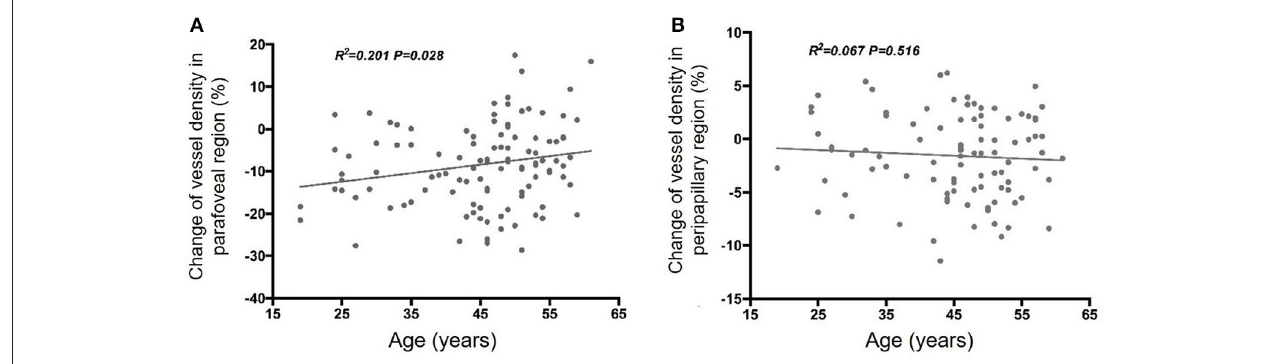
FIGURE 2 | Correlation between age and Valsalva maneuver-induced response of retinal perfused vessel density in the parafoveal (A) and peripapillary (B) regions.